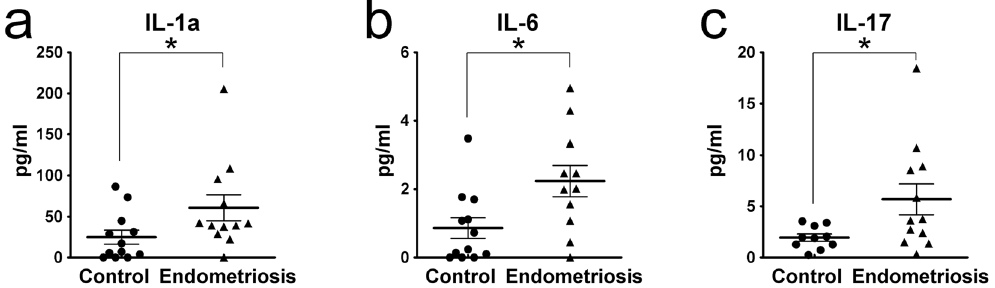
Figure 1. Endometriosis is associated with elevated serum inflammatory cytokines including ( a ) IL-1a, ( b ) IL-6 and ( c ) IL-17, compared to normal